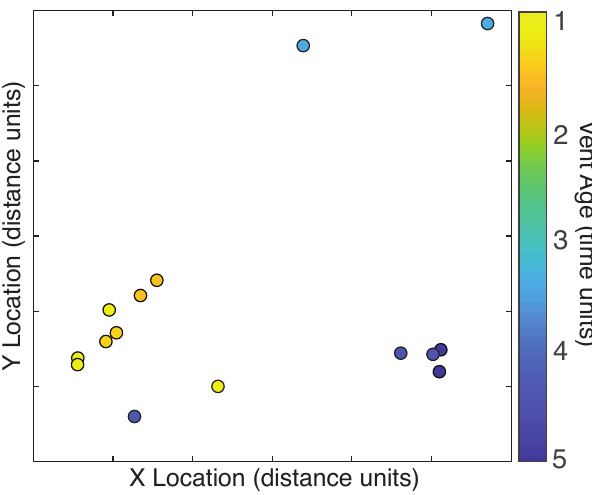
Figure 4: Simplified example vent locations with ages indicated by colour bar. The patterns represent various geometries present in volcanic fields (aligned dykes, clusters, and individual